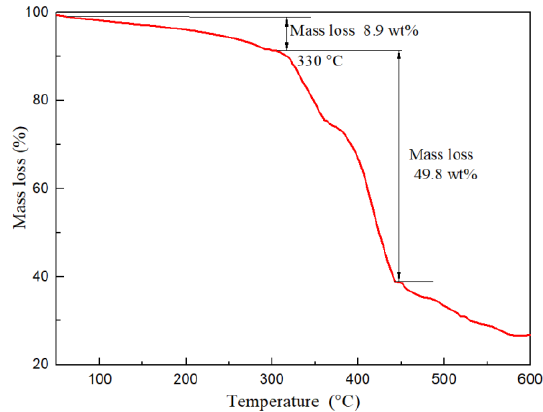
Figure 4. TG curve of